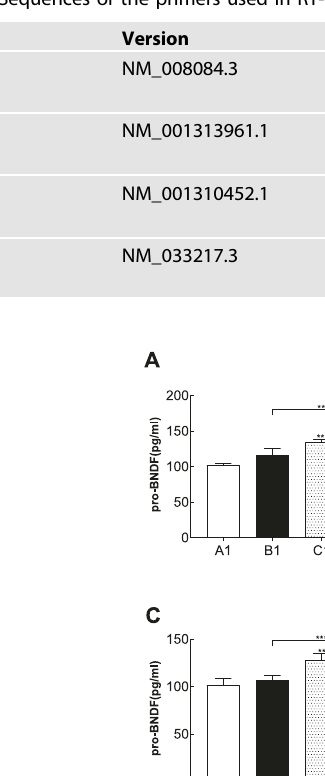
Table 2. Sequences of the primers used in RT-PCR.